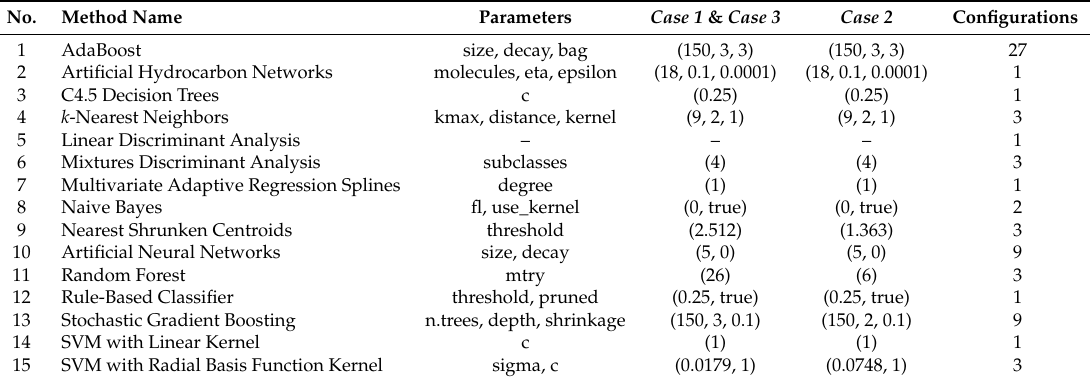
Table 3. Configuration parameters of supervised models employed with the caret package in